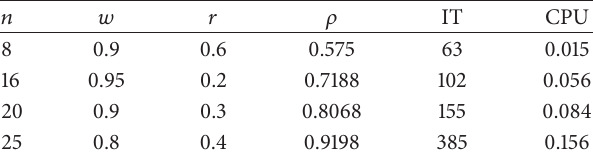
Table 1: 𝜌 , IT, and RES of QAOR.